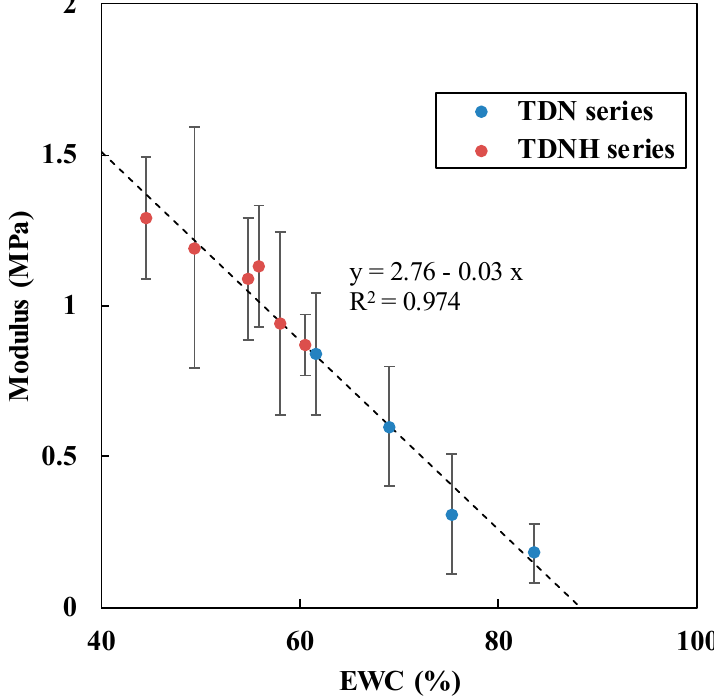
Figure 4. The correlation between the modulus and EWC for p(TRIS-DMA-NVP-HEMA).